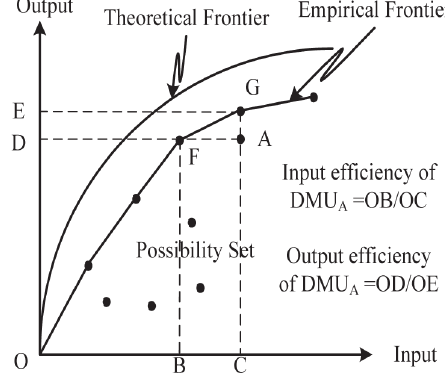
Fig. 2. DEA efficiency